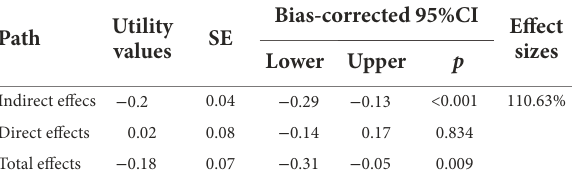
TABLE 6 Hope suppressing